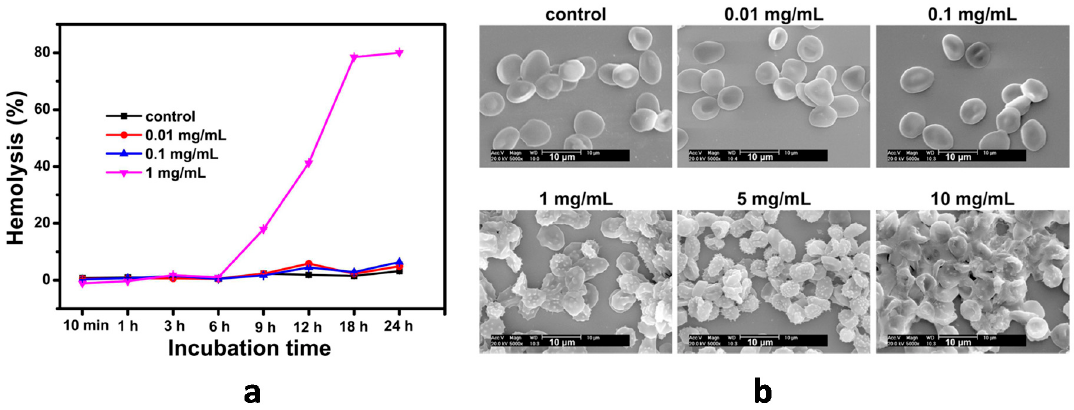
Figure 6. ( a ) Hemolysis ratio of RBCs induced by fluorescent carbon dots with different concentrations. ( b ) SEM images showing the morphology and aggregation of RBCs incubated with the fluorescent carbon dots at different concentrations. Reprinted with permission from [116]. Copyright 2015 American Chemical